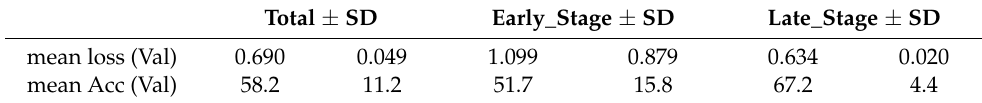
Figure 3. Performance measures of the prediction models as functions of − log10[LR]. Plotted are the loss values ( left ) and accuracies ( right ) with the Val datasets over the total period (upper), Days 1 and 2 (middle), and Days 3 to 4 (bottom) of continuous cell culture. Table 4. Mean loss(Val) and mean Acc(Val) in total, early_stage, and late_stage datasets with LR.